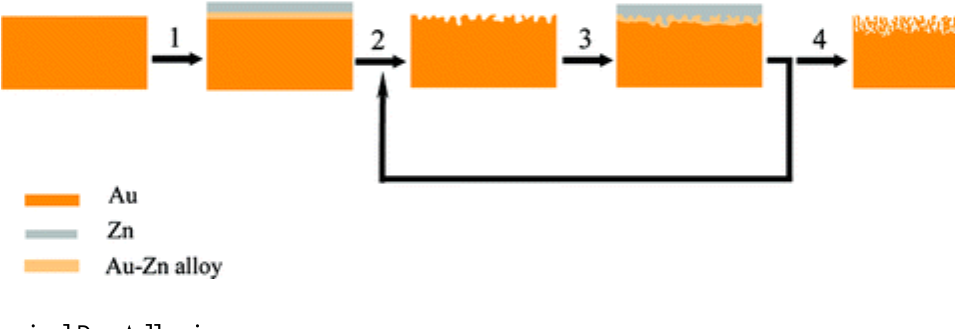
Figure 2. Schematic illustration of the formation of nanoporous gold film electrode by a multicyclic electrochemical alloying/de-alloying method. Step 1, electrodeposition of Zn and formation of Au-Zn alloy; step 2, electrochemical dealloying; step 3, electrodeposition of Zn and formation of Au-Zn alloy again; step 4, formation of nanoporous gold film after multicyclic alloying/de-alloying. Reprinted with permission from [15]. Copyright 2007, American Chemical